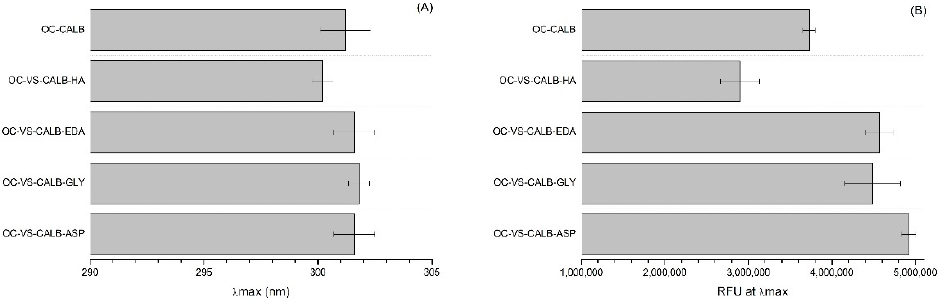
Figure 8. Intrinsic protein fluorescent of OC-VS-CALB biocatalysts blocked with different blocking reagents and octyl-CALB as reference. ( A ) Wavelength at the maximum fluorescence intensity ( λ max). ( B ) Fluorescence intensity at λ max when samples were excited at 280 nm. RFU = relative fluorescence units.